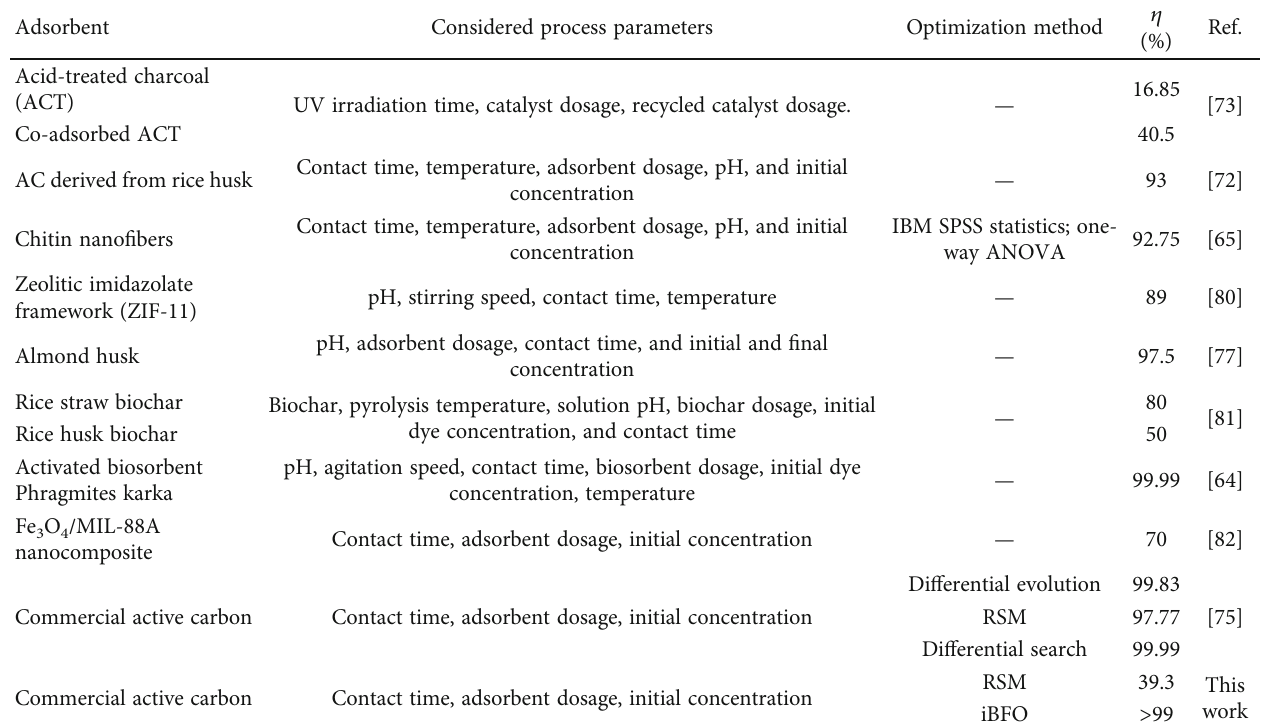
Table 7: Comparison of several adsorbents ’ e ffi ciency in decolorizing